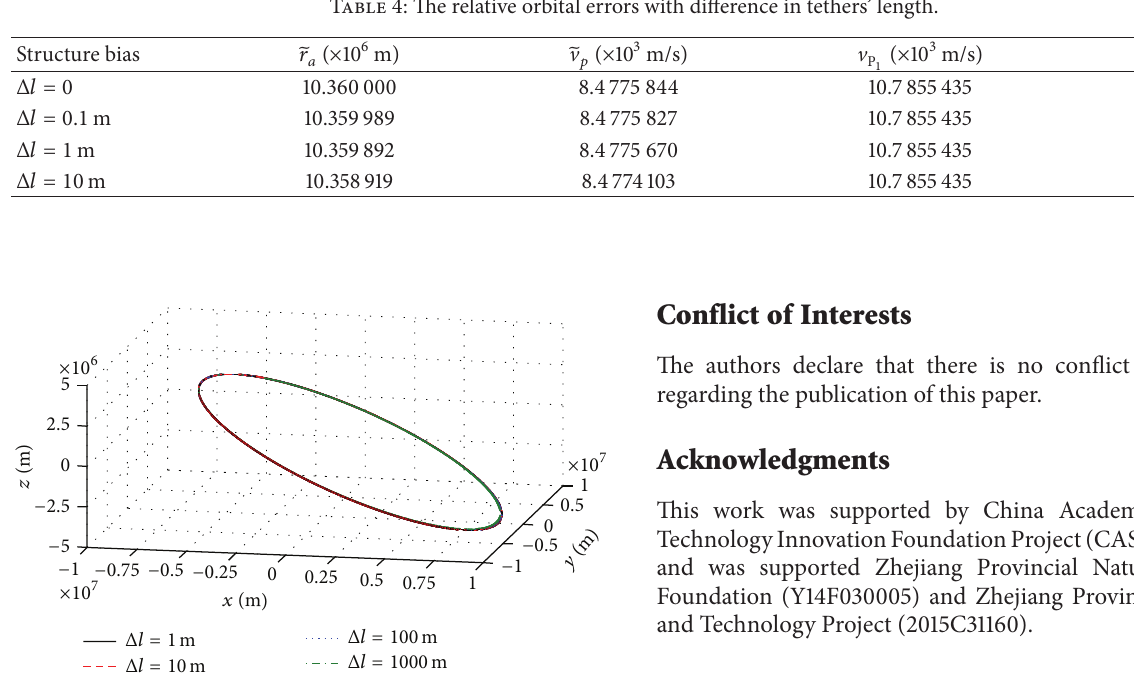
Figure 24: The orbit of MMET in geocentric equatorial inertial frame.